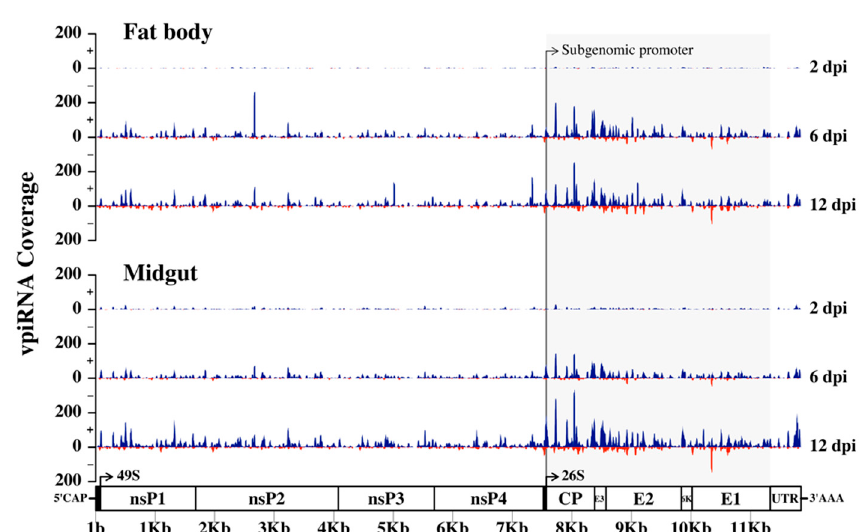
Figure 11. RRV-derived PIWI-interacting RNAs (piRNAs) generated by the fat body and midgut tissues of Ae. aegypti mosquitoes. Distribution of 27–29 nt small RNAs that mapped across the sense (blue) and anti-sense (red) strands of the RRV genome at 2, 6, and 12 dpi. Distinct 3’ hotspots indicate virus-derived piRNA (vpiRNA) production against the subgenomic RNA.